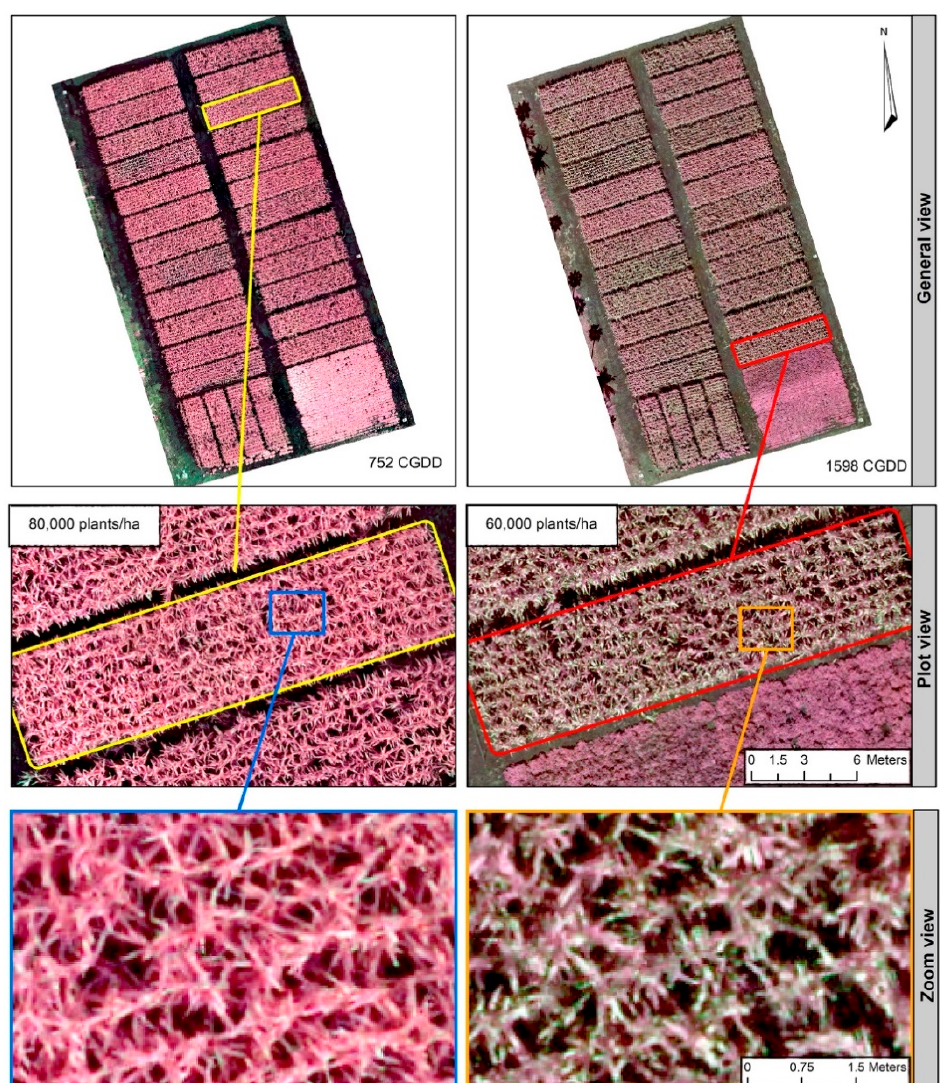
Figure 2. The automated workflow implemented in Pix4D batch-processing. Adapted from [38].